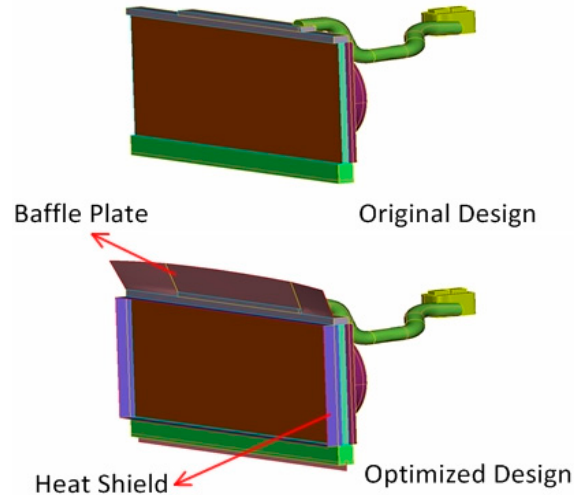
Figure 26. Radiator optimization scheme.